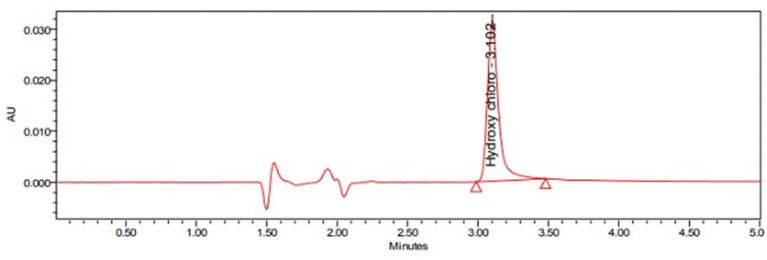
Typical Chromatogram of Hydroxy chloroquine sulfate standard.